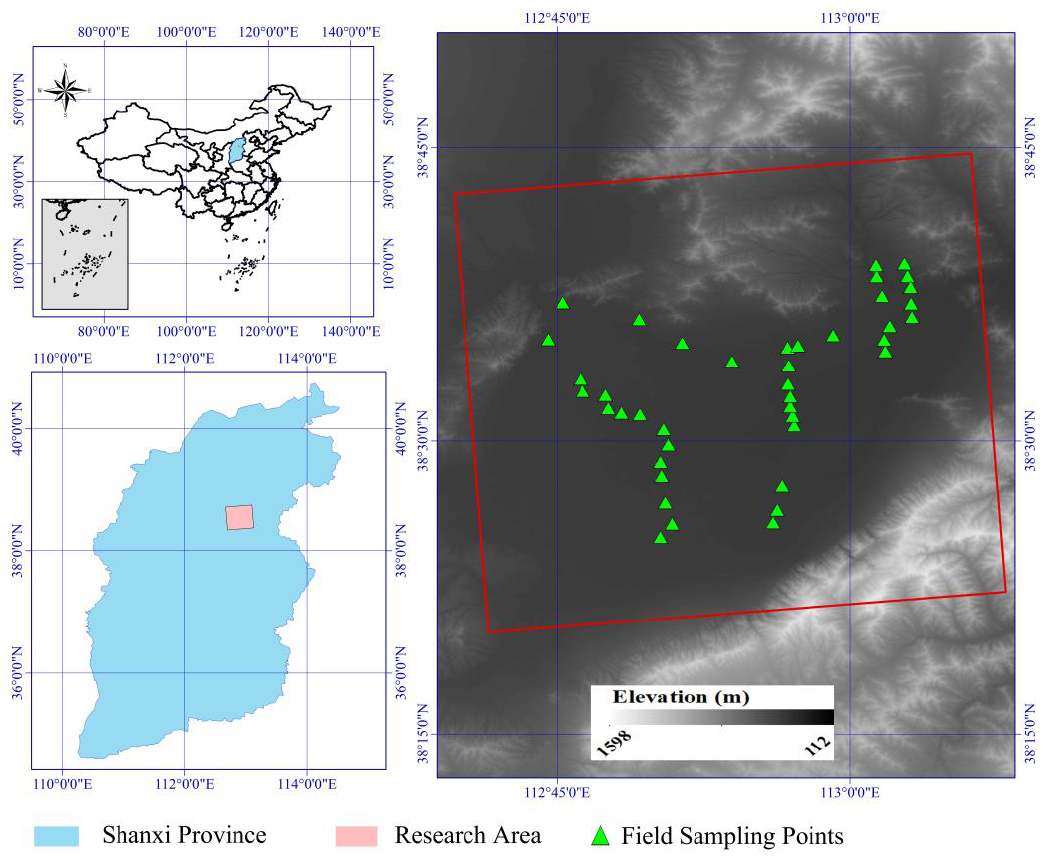
Figure 1. The study area and field-sampling points.